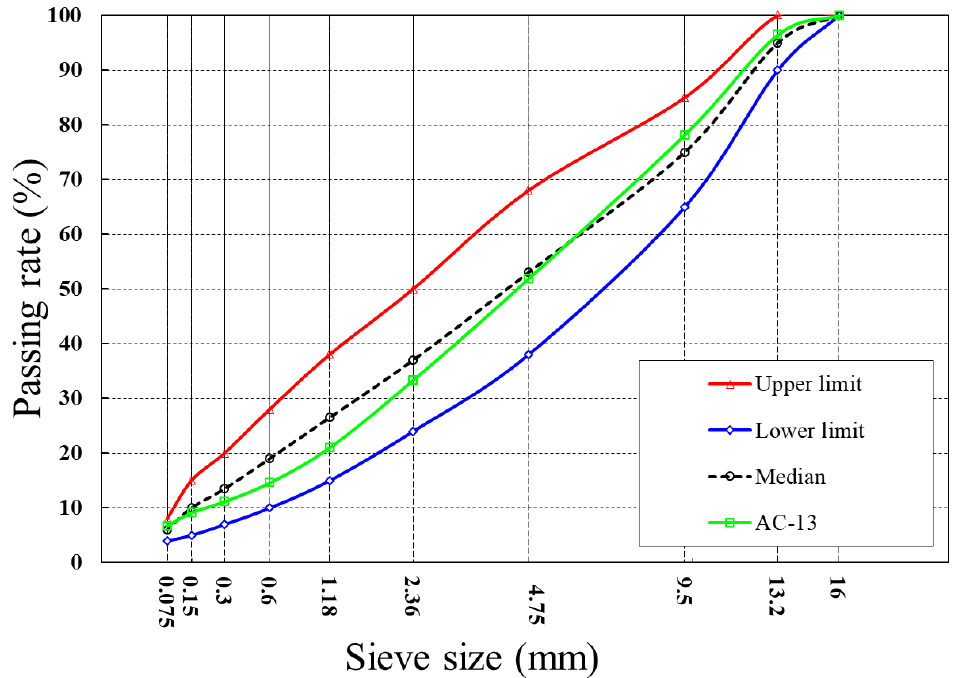
Figure 2. The aggregate gradation of AC-13 mixtures.